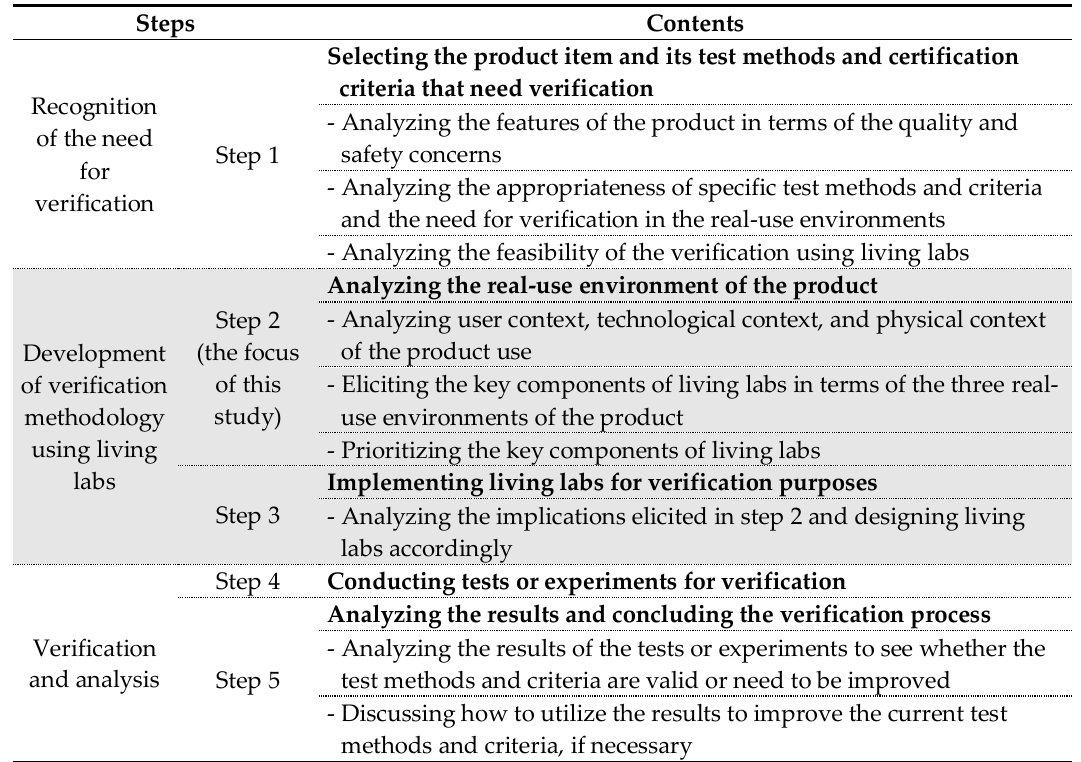
Table 1. The Five-Step Process of Verification Using Living Labs.